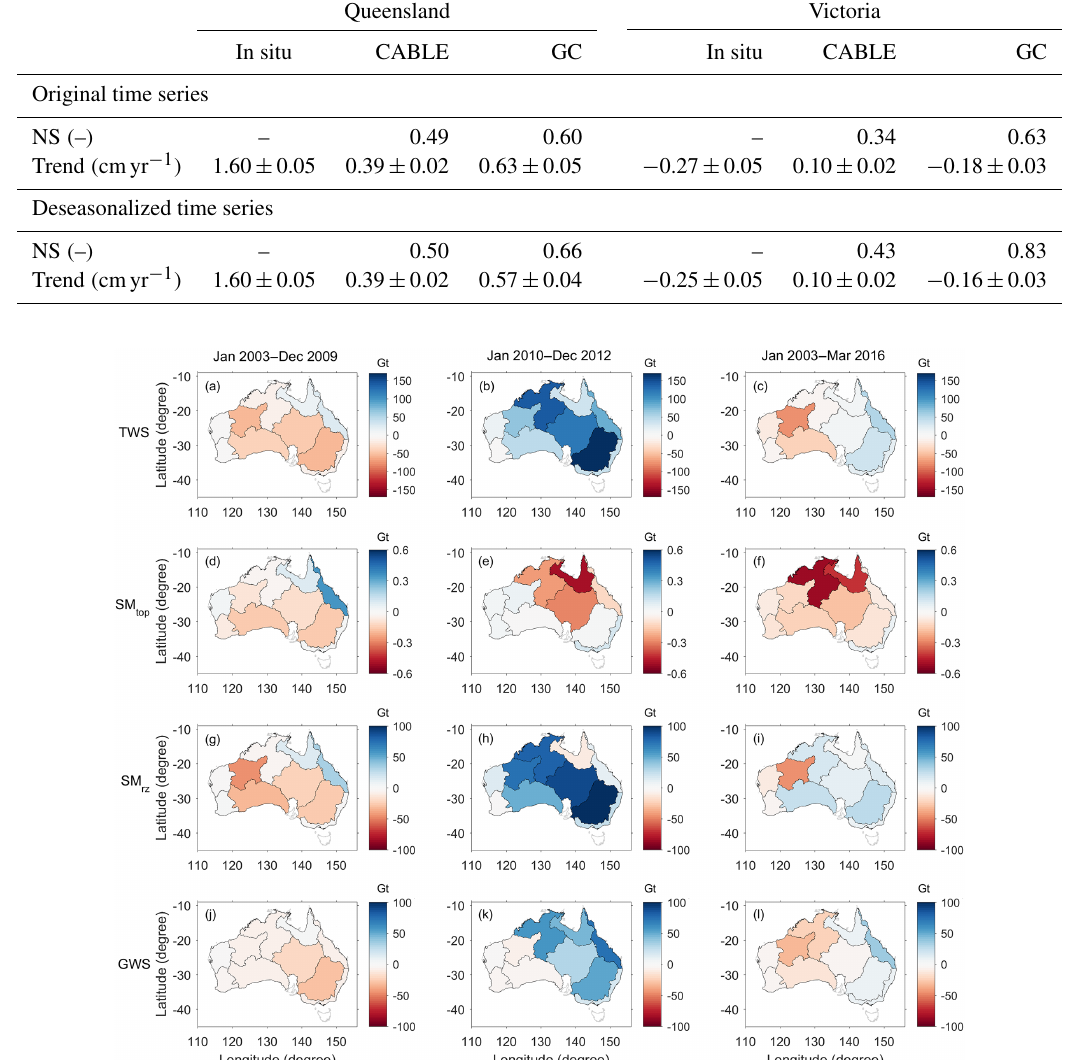
Figure 10. Mass changes (Gt, Gigatonne) of (cid:49) TWS, (cid:49) SM top , (cid:49) SM rz , and (cid:49) GWS estimated from GC solutions over 10 Australian